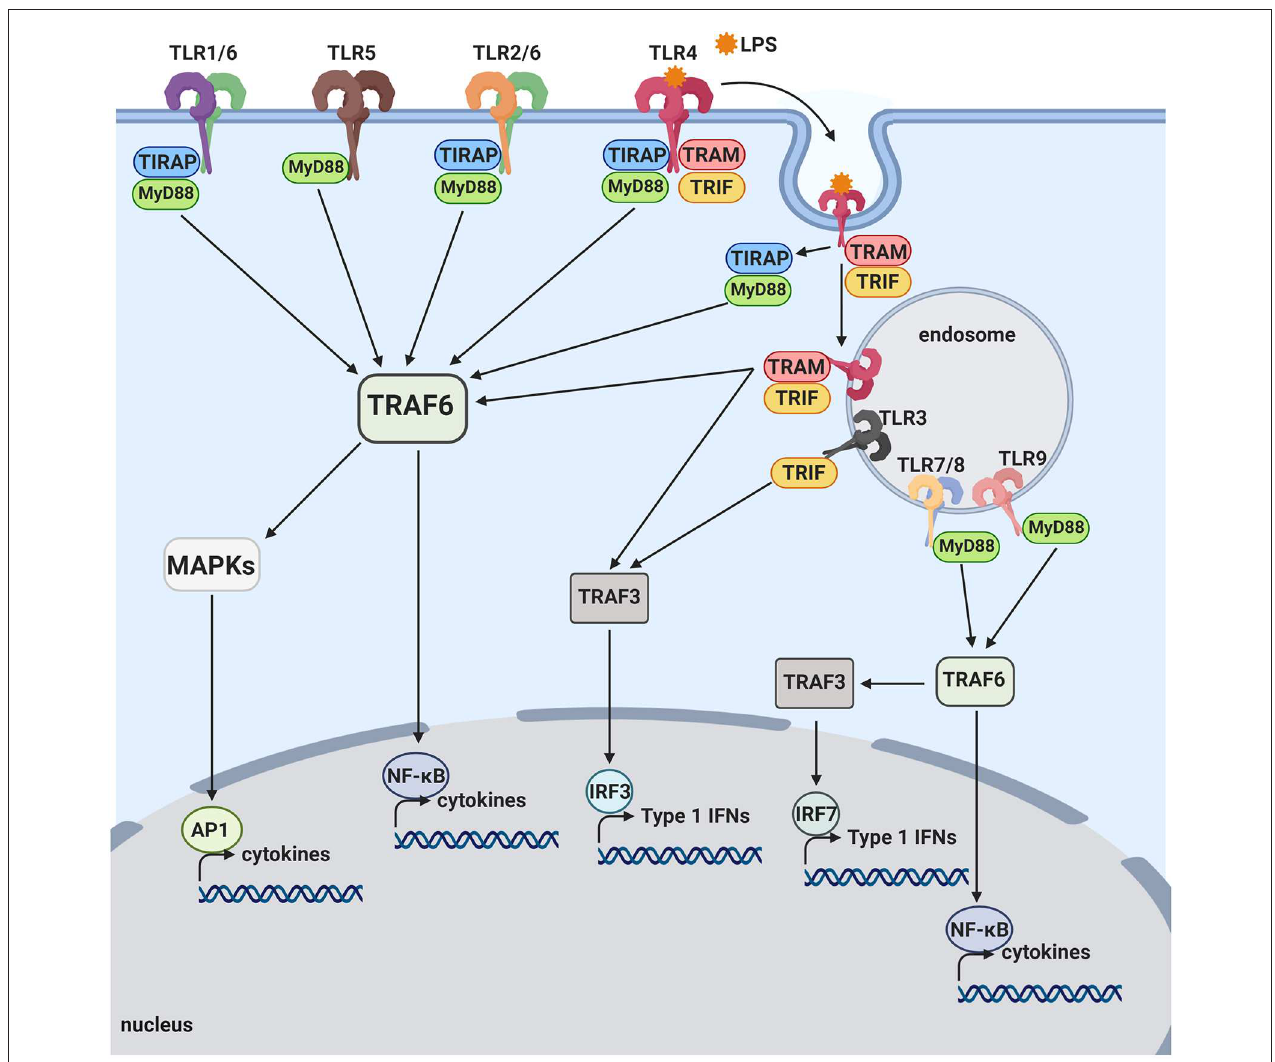
FIGURE 1 | Toll-like receptor pathways. TLR1, TLR2, TLR4, TLR5, and TLR6 are mostly expressed on the cell surface and bind to bacterial products. When activated by LPS, TLR4 is internalized onto an endosome surface. The internalization triggers the release of TIRAP/MyD88, activating the TRAF6 pathway and resulting in activation of transcription factors, NF- k B and AP-1. The release of TIRAP/MyD88 from TLR4 allows for the signaling by TRAM/TRIF to commence from the endosome, also activating NF- k B as well as the transcription factor, IRF3. TLR3, TLR7, TLR8, and TLR9 are located on internal vesicles and bind to bacterial and viral nucleic acids. TLR7, TLR8, and TLR9 each activate NF- k B, as well as the transcription factor, IRF7, through the MyD88 pathway. TLR3 is the only toll-like receptor that does not activate via the MyD88 pathway and instead activates NF- k B and IRF3 through the TRIF pathway.